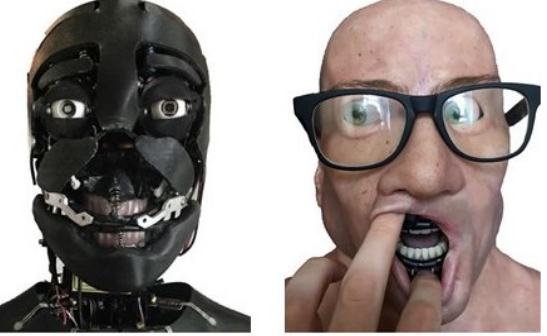
Figure 9 . Robotic eye installation in RHR ‘Baudi’ for testing. Left : Exoskeleton. Right : Finished robot with skin and gelatin eye membranes.